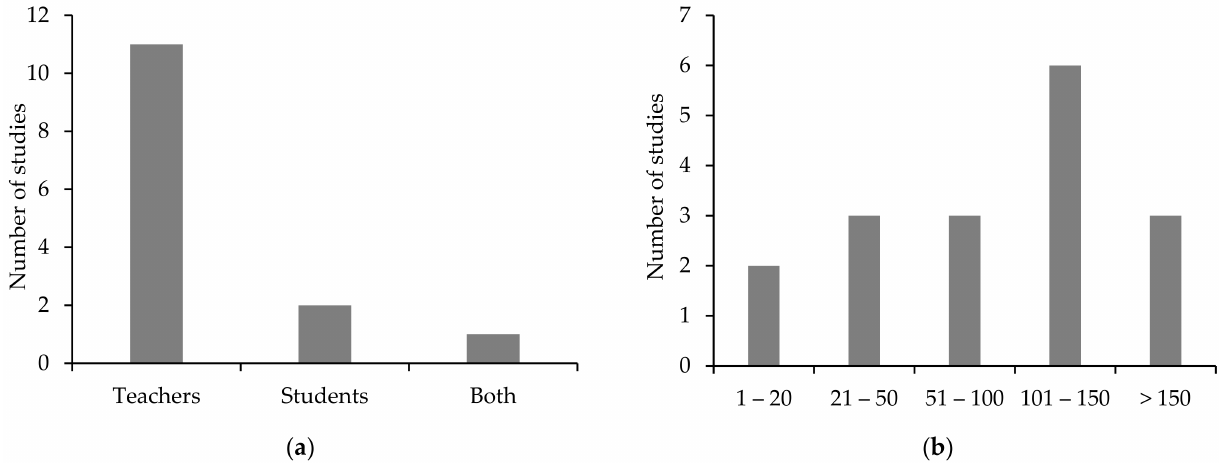
Figure 3. Summary of studies in terms of ( a ) participants and ( b ) sample size.